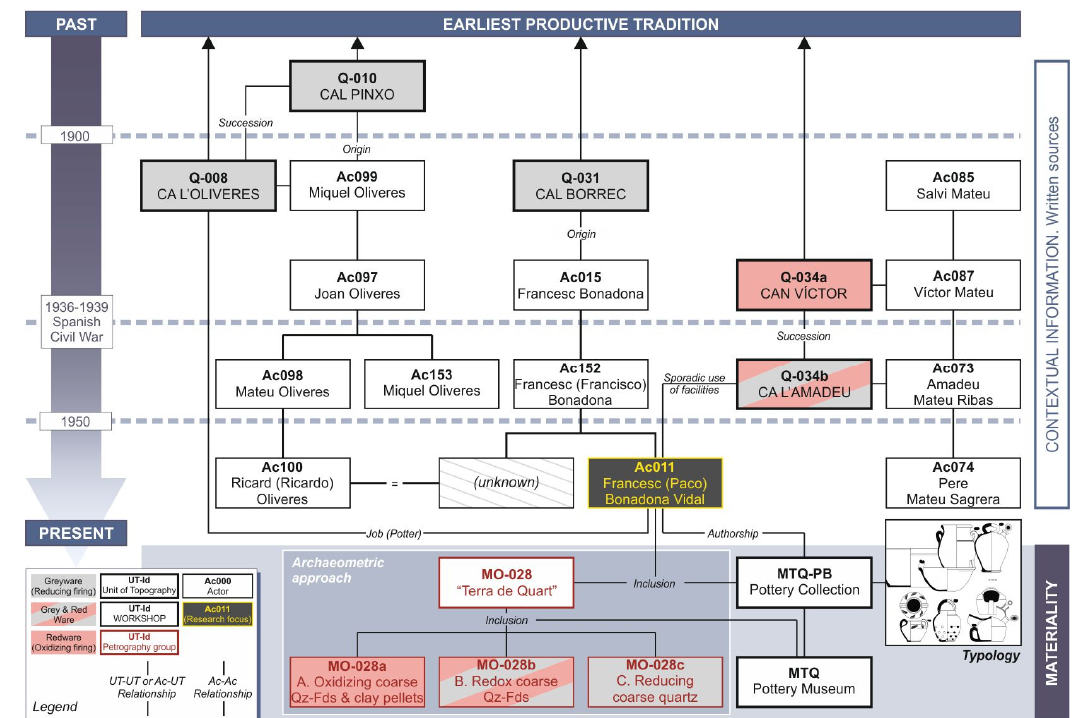
Figure 8. Harris-like historical matrix of the existing relations between the potter Paco Bonadona (Ac011) and the pottery production at the town of Quart (Girona, Spain). The information obtained from published references [76] is exploited together with the interdisciplinary pottery analysis performed at the former Pottery Museum of Quart (MTQ).